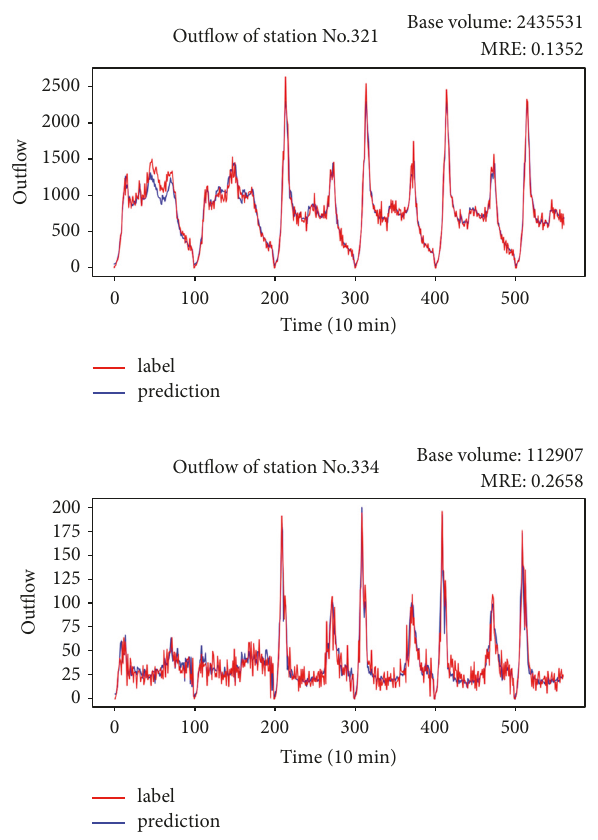
Figure 3: Influence of base volume in